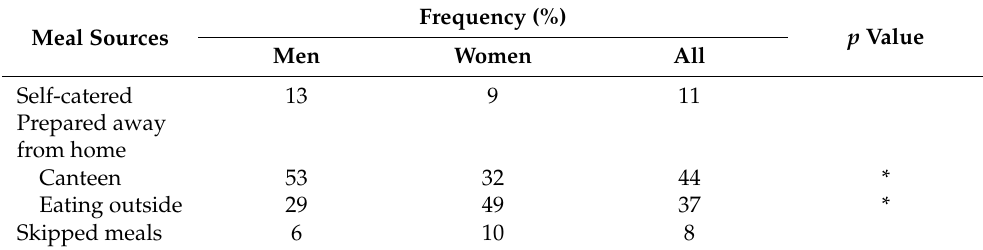
Table 1. The frequency of students’ dietary habits on five consecutive weekdays ( n = 333). Frequency (%) p Value Meal Sources Men Women All Self-catered 13 9 11 Prepared away from home Canteen 53 32 44 * Eating outside 29 49 37 *